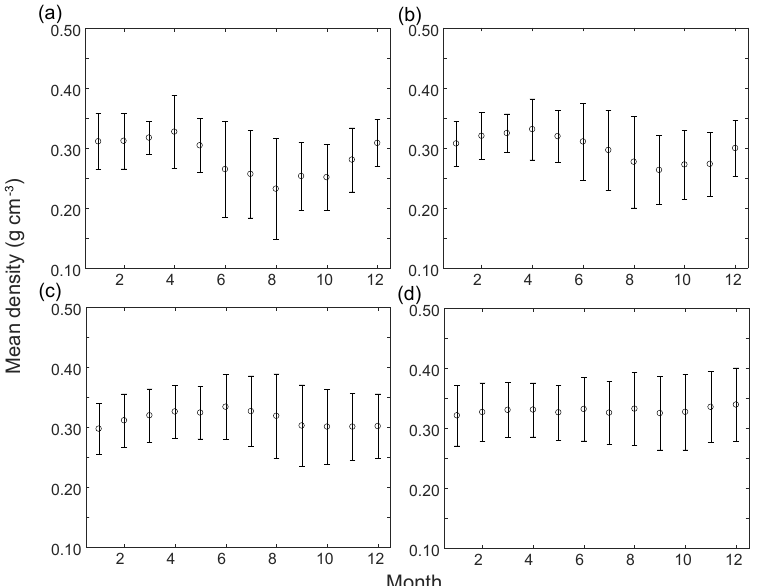
Figure 12. Plot of mean density (circle) and ± 1 standard deviation (whiskers) for each month at Summit Station, Greenland, for (a) 10cm, (b) 25cm, (c) 50cm, and (d) 100cm.